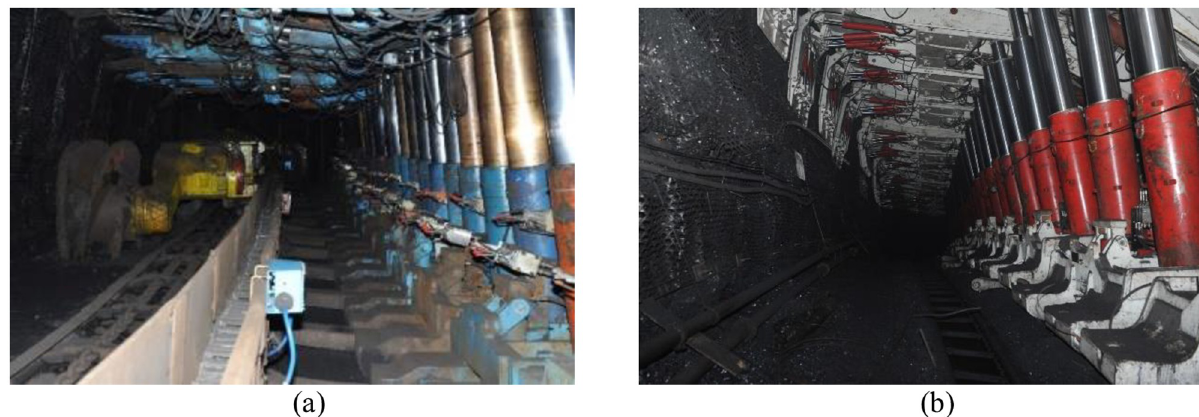
Fig 14. Shield in some typical coal seams. (a) ZY6400-21/45 in No.7 coal seam; and (b) ZY4800-13/32 in No.8 coal seam.